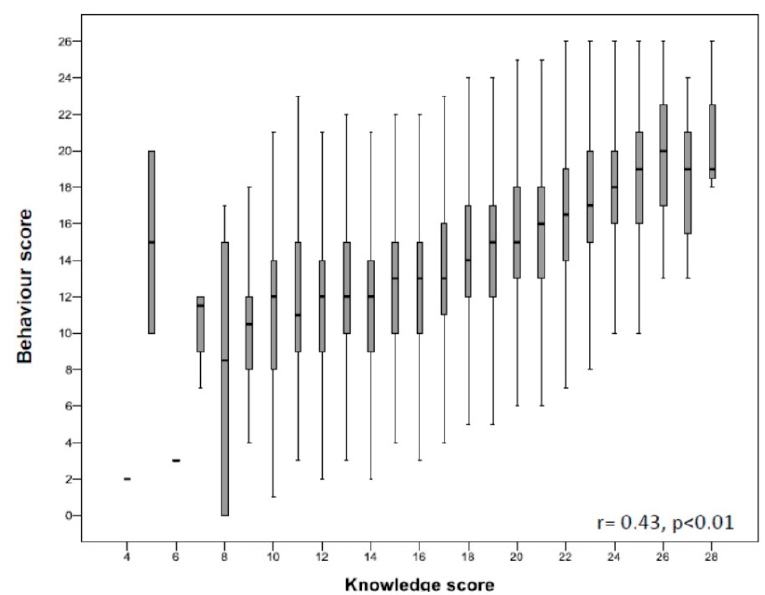
Figure 4. Relationship between knowledge and behaviour about salt consumption. Results are